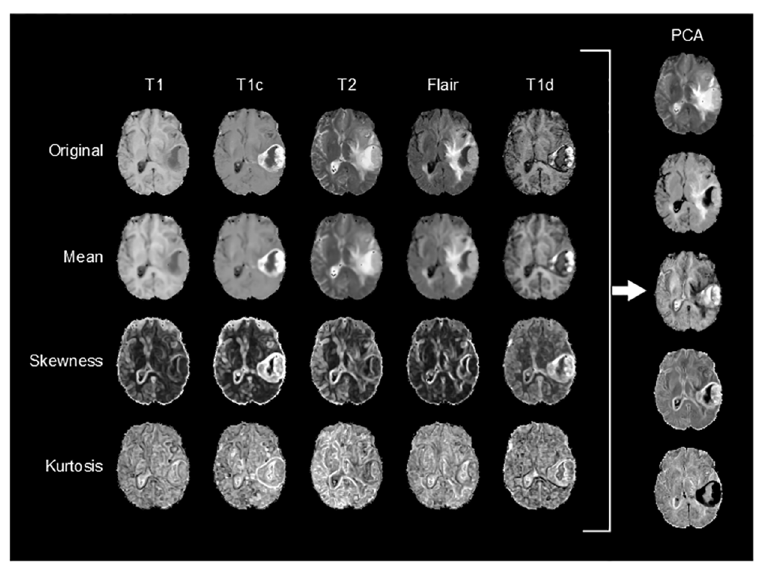
Fig 3. Example of feature extraction and dimensionality reduction from a patient of the BRATS 2013